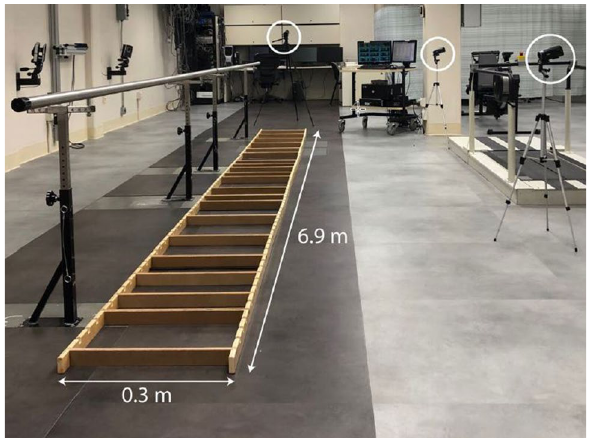
Figure 1. Experimental setup. Able-bodied volunteers and below-knee amputees performed a horizontal ladder rung walking test while blindfolded. Ladder rungs were randomly spaced 19, 28.5, 38, or 47.5 cm apart and the arrangement changed after every trial. Participants used a single handrail that ran alongside the ladder for support. Videos were recorded with three cameras, two alongside the ladder and one at the